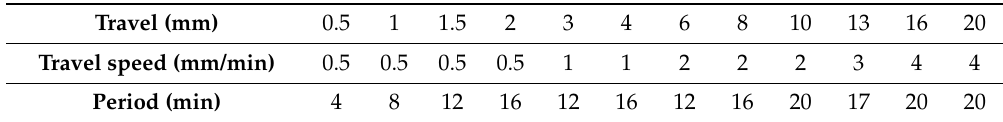
Figure 6. Displacement history. Table 2. Displacement